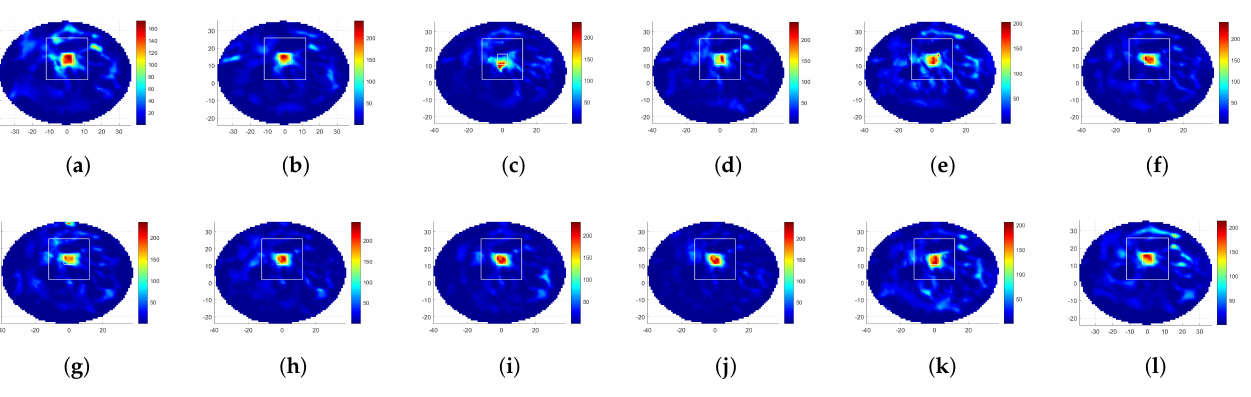
Figure 4. Results of focusing at target-I with the 12-antenna linear MH applicator: ( a – l ) SAR distribution (W/kg) for θ = 0°, 15°, 30°, 45°, 60°, 75°, 90°, 105°, 120°, 135°, 150°, and 165°. The white squares depict the target (inner) and healthy region (outer) boundaries used for the SAR and temperature metric calculations (the axes are in mm). Table 1. Focusing results of the linear MH applicator at target-I with changing the antenna number and rotation